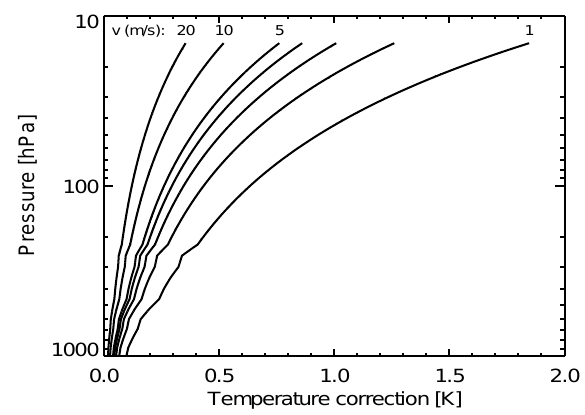
Figure 6. Profiles of the GRUAN radiation temperature correction for ventilation speeds between 1 and 20 ms − 1 . The correction was calculated for a radiosounding performed in Lindenberg on 17 September 2013, 12:00UTC. The kinks in the profiles between 900 and 200 hPa result from the cloud configuration that was used in the streamer simulations, with cloud layers between 4–6 and 7–10 km , which introduces jumps in the simulated radiation profile at the top of the cloud (see the dashed traces in Fig. 5). The maximum solar zenith angle during the sounding was 36.5 ◦ .